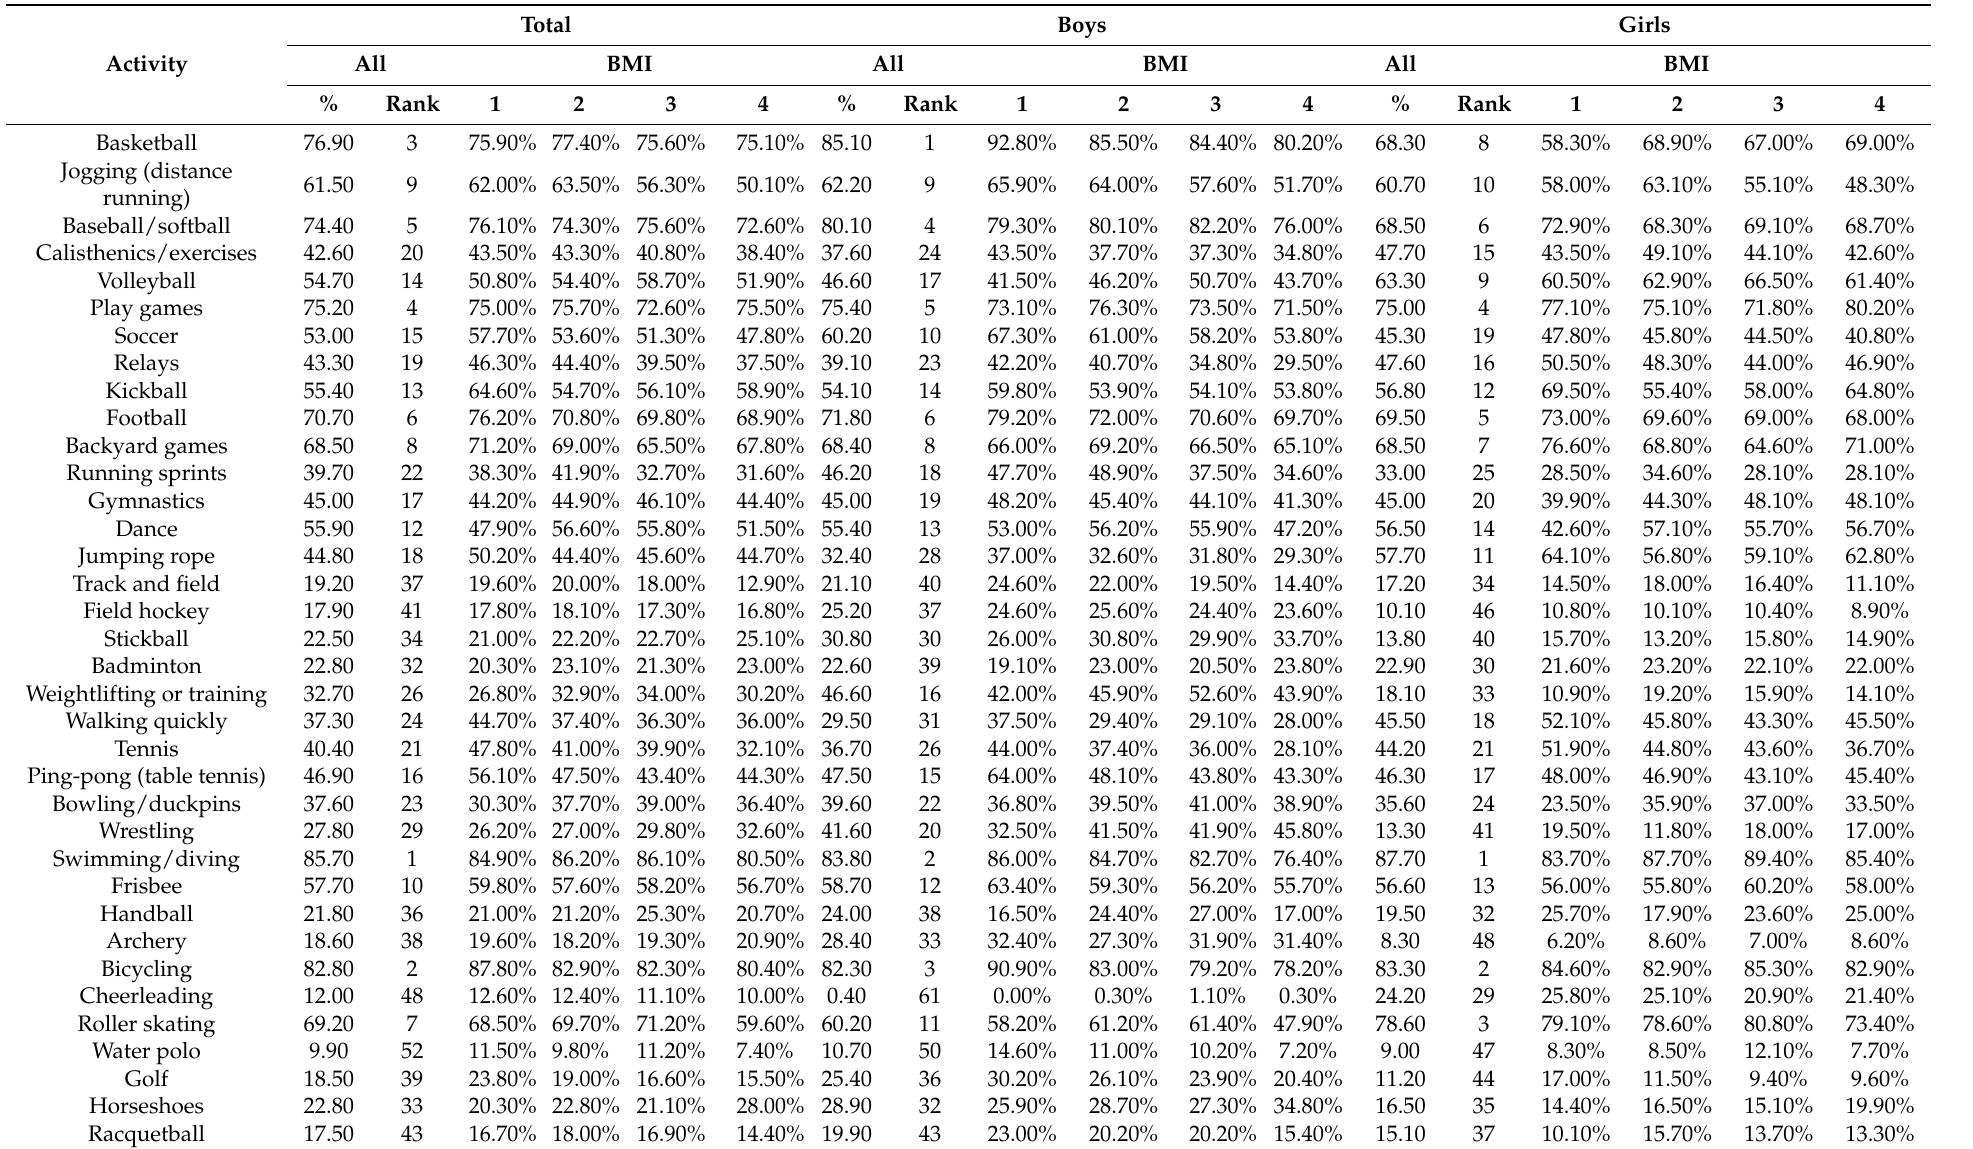
Table 3. Ranking of physical activities out of school PE in 1985 (BMI: 1 = Underweight, 2 = Normal weight, 3 = Overweight, 4 =